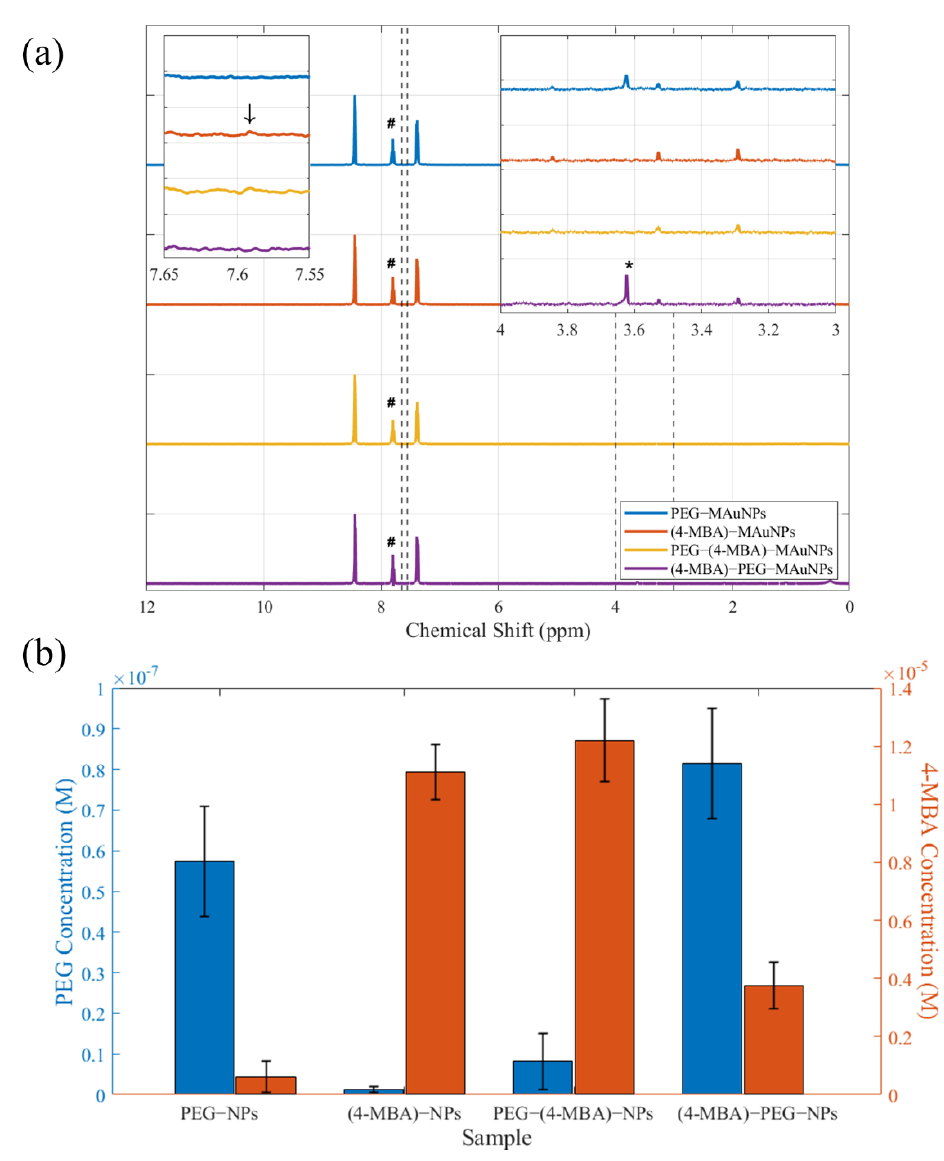
Figure 6. ( a ) NMR spectra of PEG-MAuNPs (blue), (4-MBA)-MAuNPs (red), and PEG-(4-MBA)- MAuNPs (yellow). All samples were incubated in 2 mM mPEG-SH solution and/or 0.1 mM 4-MBA solution. Insets ranges are denoted by vertical dashed lines. ( b ) Calculated concentrations of PEG (blue) and 4-MBA (orange) from spectra in ( a ) using pyridine reference peak denoted by #. Table 2. PEG and 4-MBA graft densities, as calculated by Equation (2). Error values shown were calculated using the standard deviation of the NMR data and the TEM D MAuNP data.